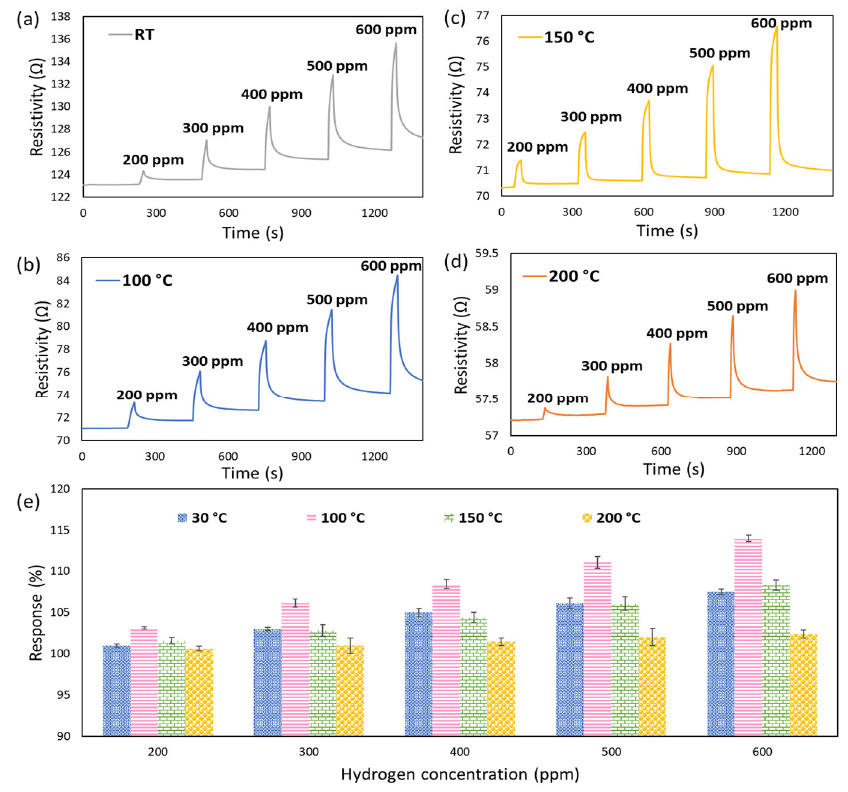
Figure 7. P-type semiconducting gas sensing dynamic responses of CeO 2 -Pd-PDA/rGO sensor towards H 2 with different concentrations without UV illumination at different working temperatures ( a ) 30 °C, ( b ) 100 °C, ( c ) 150 °C, and ( d ) 200 °C. ( e ) Response values at different operating temperatures and H 2 concentrations.